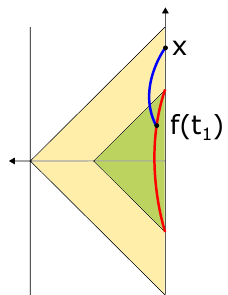
Figure 8 . Penrose diagram of the AdS 2 Poincaré patch (large triangle), with the black hole Penrose diagram embedded within (smaller green triangle). A bilocal operator (6.1) (blue) has one endpoint on the wiggly boundary curve (red) at proper time t and another endpoint at Poincaré time x , 1 which might be beyond the black hole horizon as it is here. The vertical axis measures global time, and the horizonal axis the global radial